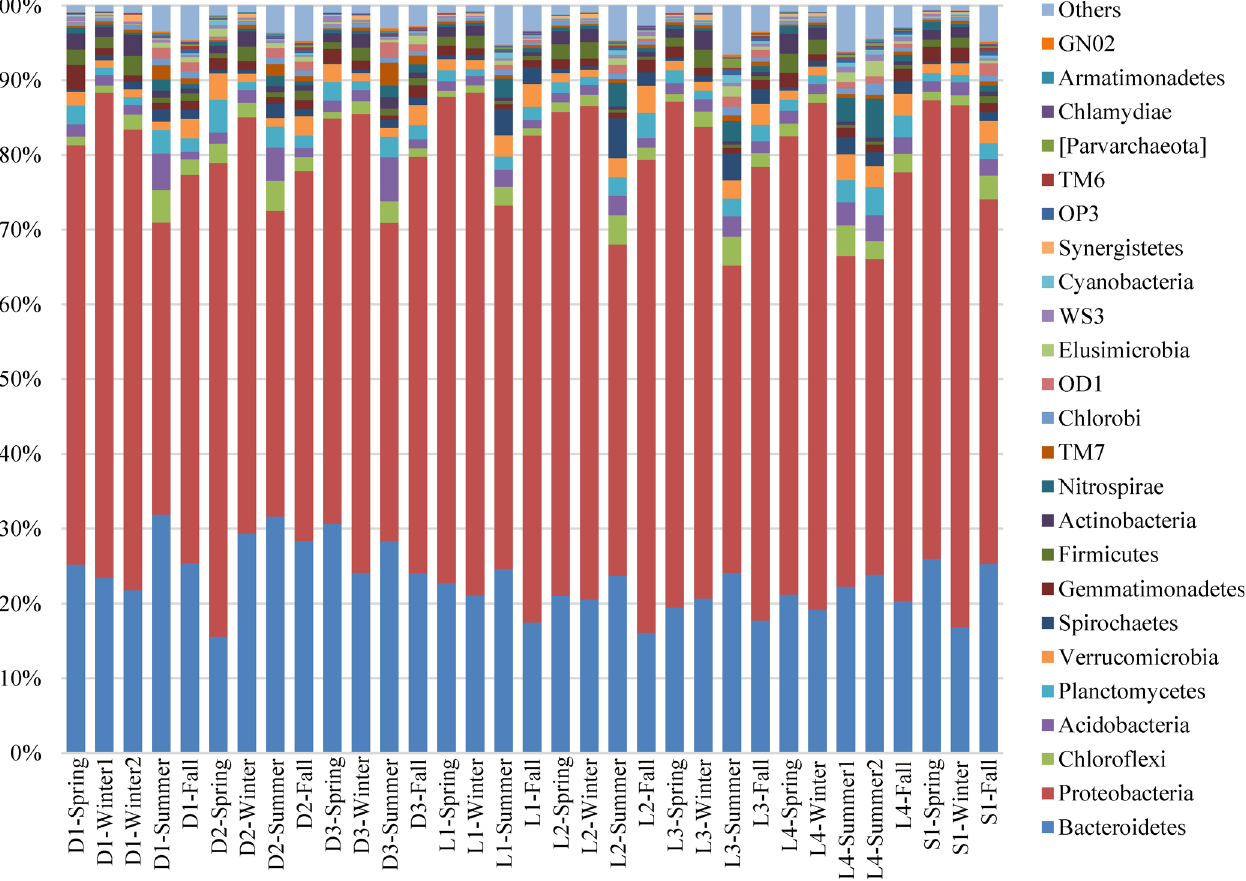
Fig 1. Abundances of different phyla in the 33 activated sludge (AS) samples. The abundance is presented in terms of percentage in total effective bacterial sequences in a